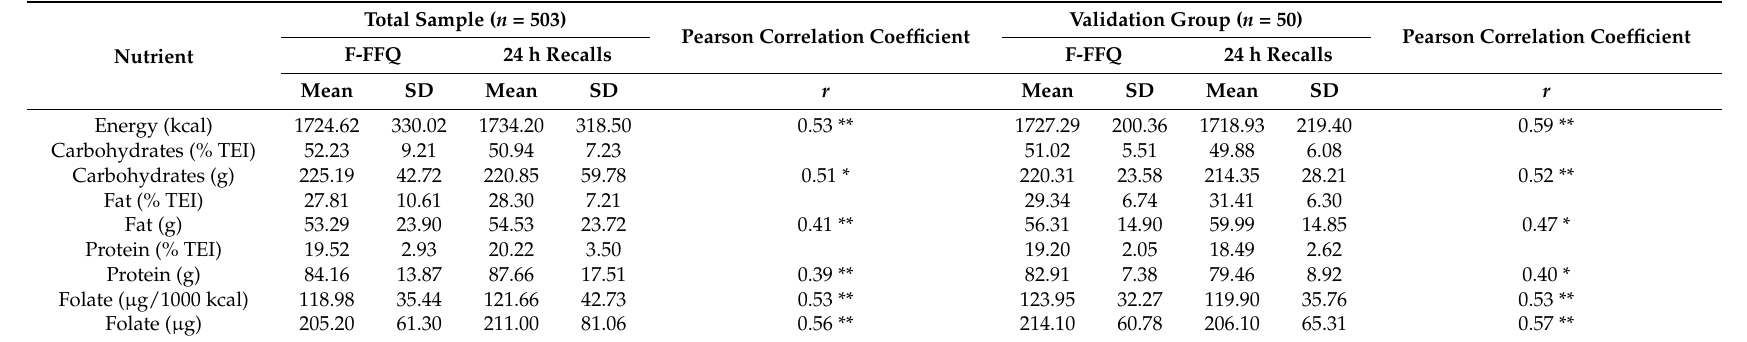
Table 1. Daily energy and nutrient intake assessed by the F-FFQ and average of the three 24 h dietary recalls with correlations between the estimates of the dietary intake by applied questionnaires among Serbian women of reproductive